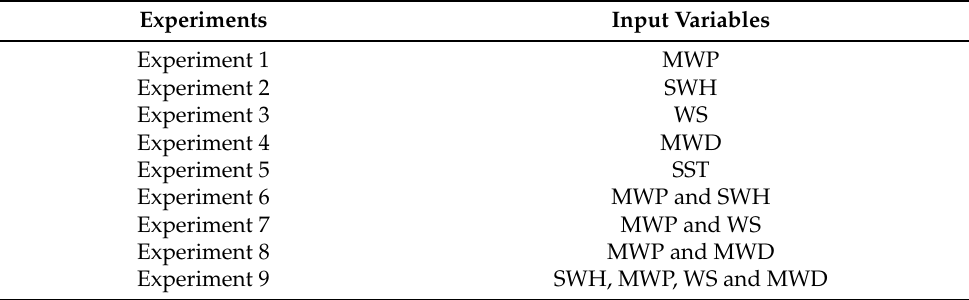
Table 3. Details of the input variables for experiments 1 to